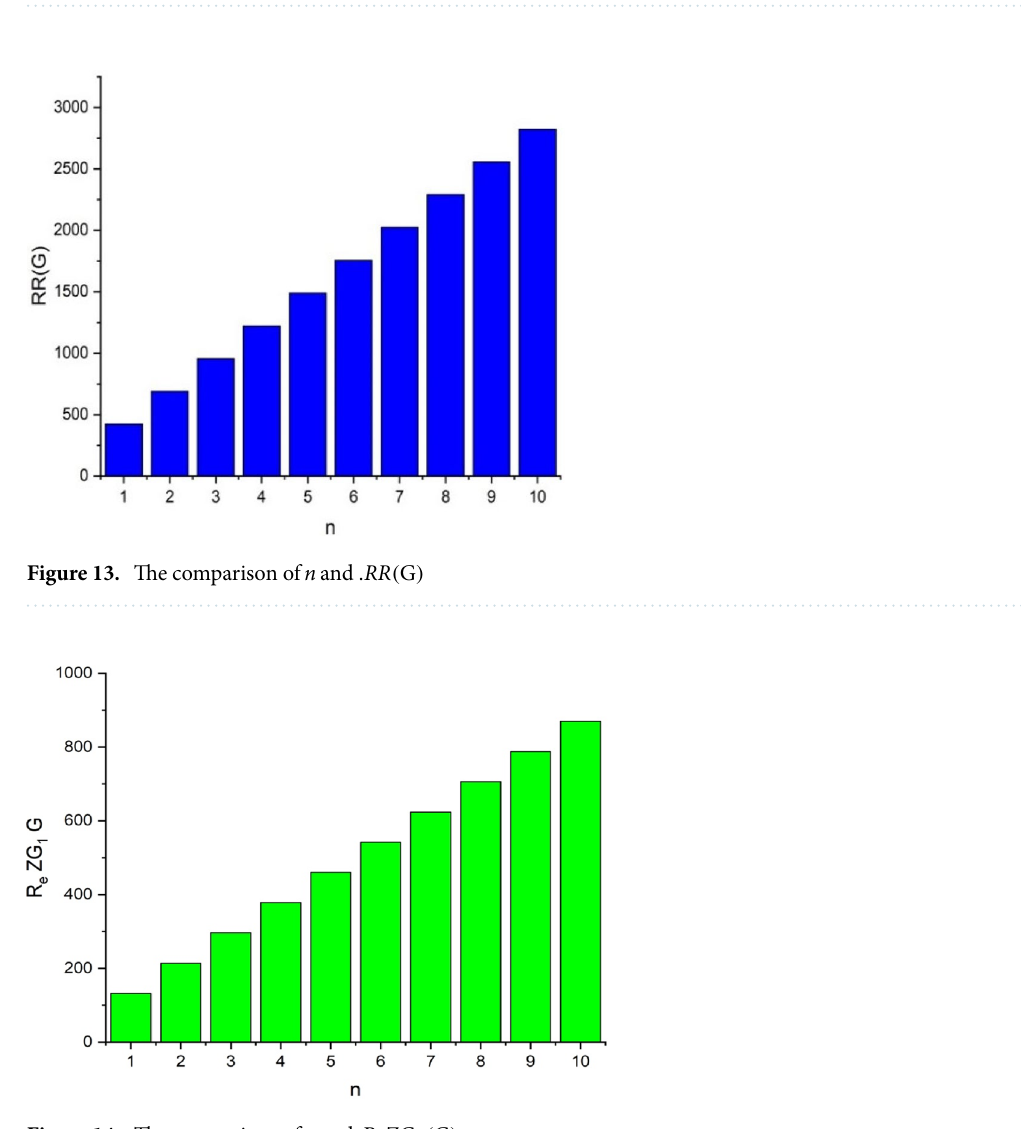
Figure 14. The comparison of n and . R e ZG 1 ( G